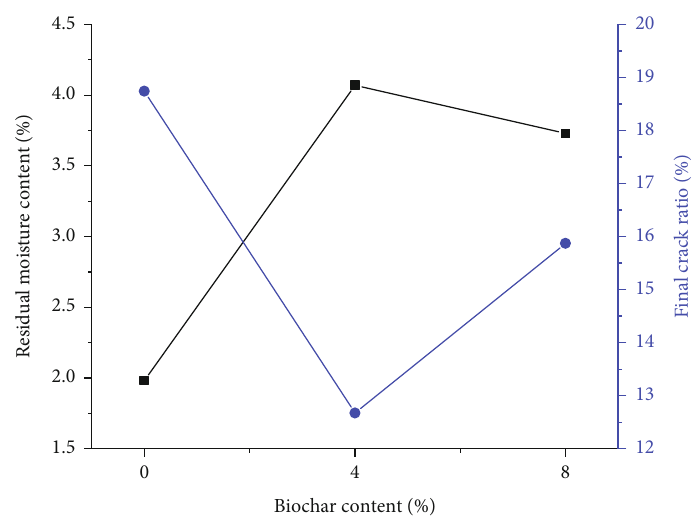
Figure 3: Relationship between residual moisture content, fi nal crack ratio, and biochar